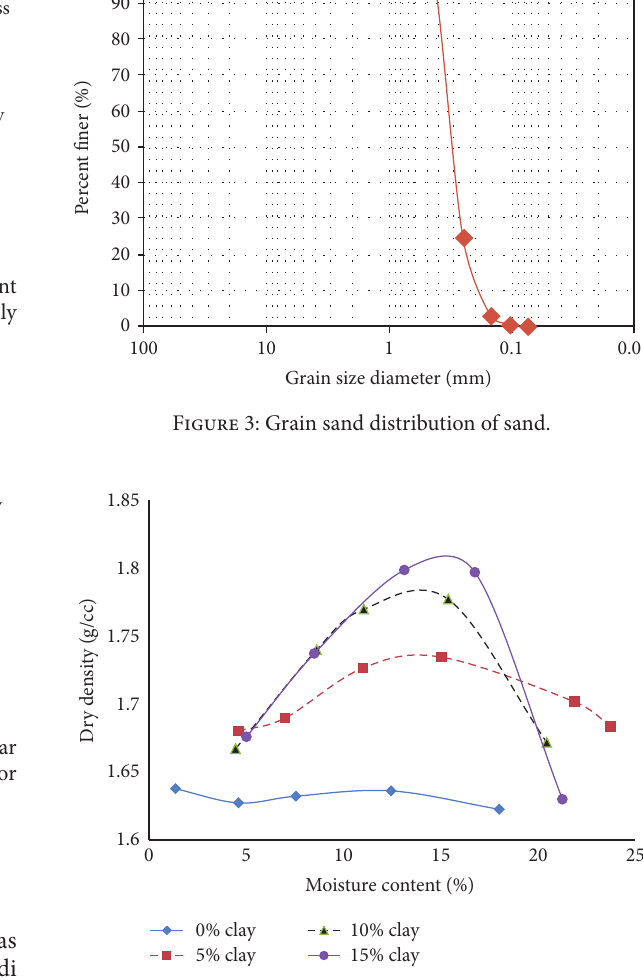
F 4: Compaction curves for sand-clay mixtures with different clay content.